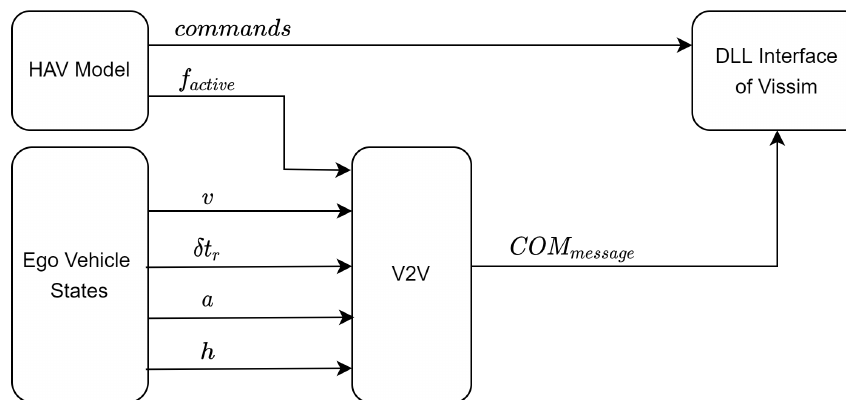
Figure 7. CAV model in the driving model.